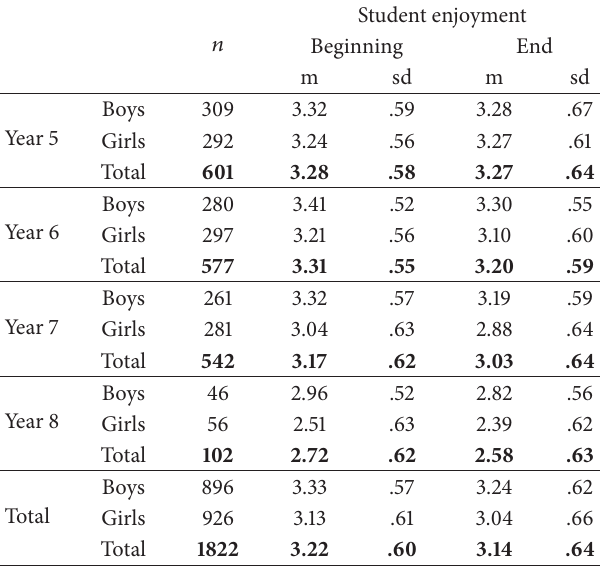
Table 1: Descriptive statistics of beginning and end of school year student attitudes towards science and technology (range